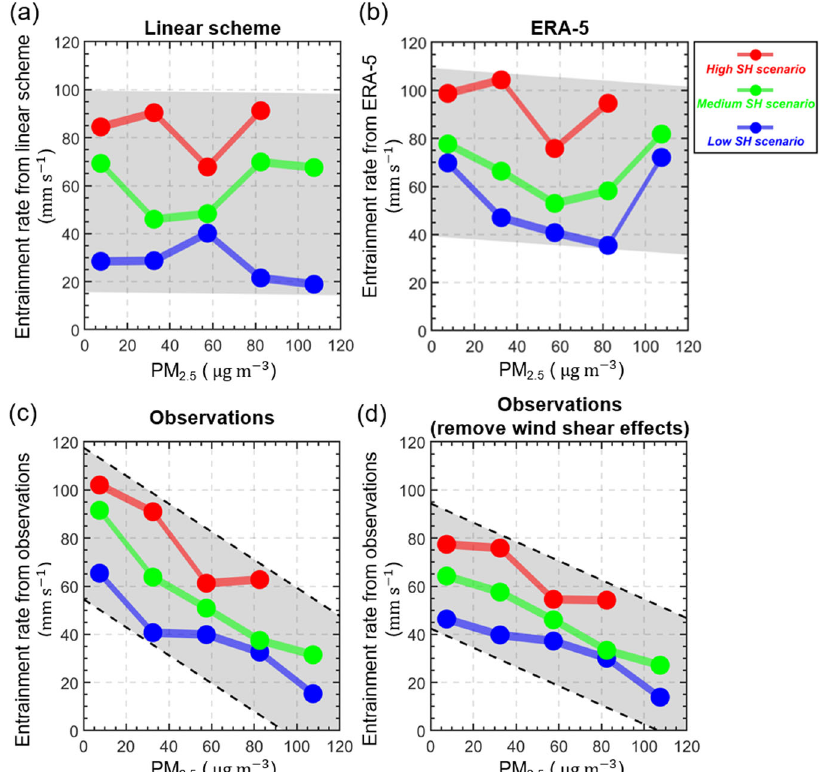
Fig. 4 Sensitivity of entrainment to PM 2.5 observations based on different data sources. Red, green, and blue lines show how entrainment rates change as PM 2.5 changes under a high SH scenario (percentile: 66 – 100%), the medium SH scenario (percentile: 33 – 66%), and the low SH scenario (percentile: 0 – 33%), respectively. The entrainment rates are derived from a the linear scheme using radiosonde and SH observations as input, b ERA-5 reanalysis data, c PBLH observations ( w e ¼ dz i = dt (cid:2) w i ), and d PBLH observations removing wind shear effects. Due to the availability of radiosonde data, we only compare results during noontime (12:00 – 14:00 local time) in the warm season (June to September). The grey shaded areas represent the averaged linear regression. The black dash lines indicate the regressions are statistically signi fi cant at the 99% con fi dence